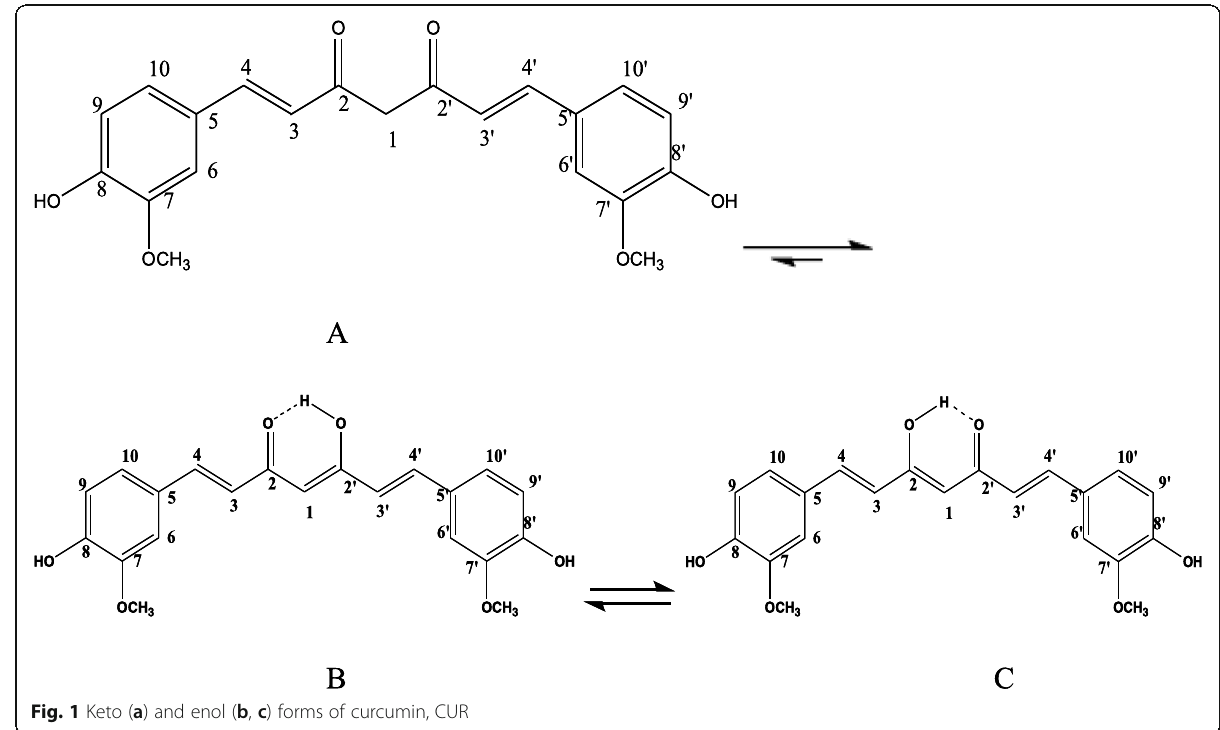
Fig. 1 Keto ( a ) and enol ( b , c ) forms of curcumin,